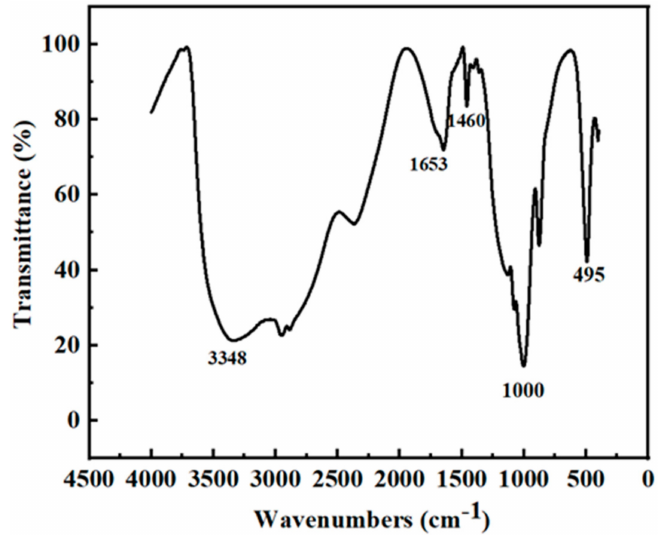
Figure 3. FT-IR spectrum of the PEI-CQDs.